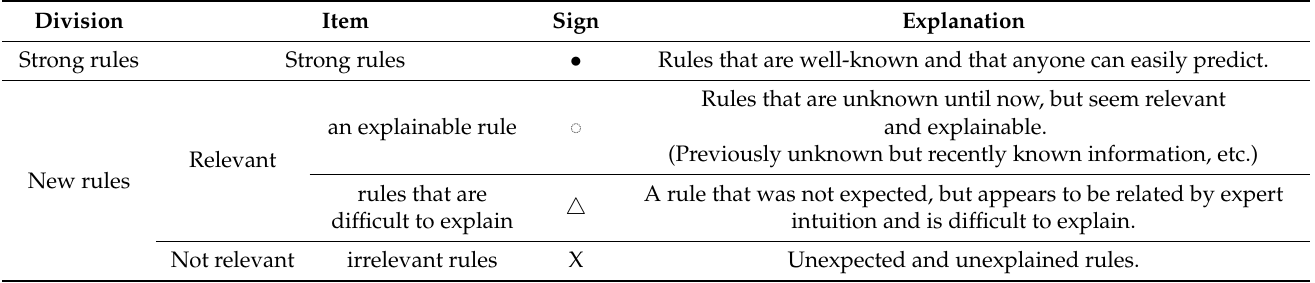
Table 3. Association rule classification system through expert